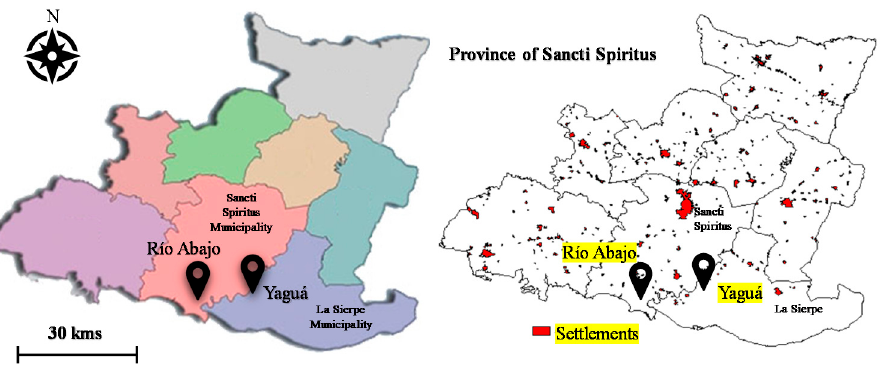
Figure 1. Map of Sancti Spiritus province and location of Yaguá and Río Abajo communities.